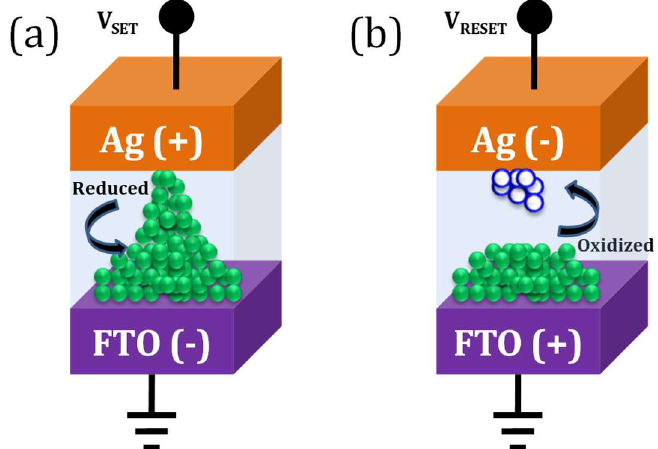
Figure 7. Possible filamentary resistive switching mechanism of the Ag/ZnO/FTO thin film memristive device during ( a ) ON state or LRS and ( b ) OFF state or HRS.